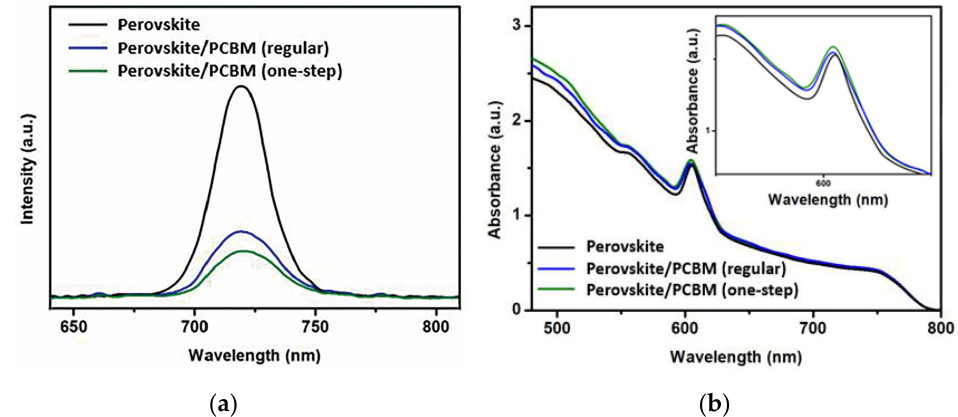
Figure 4. ( a ) PL spectra and ( b ) UV absorbance of samples with configuration of perovskite, perov-